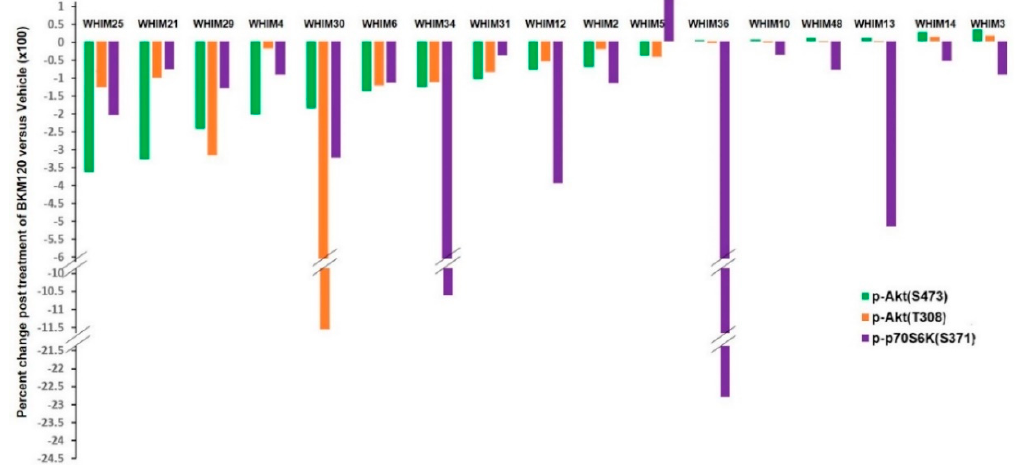
Figure 3. BKM120 induced inhibition of PI3K pathway signaling in TNBC PDX models. Table 2. Baseline protein markers of response to